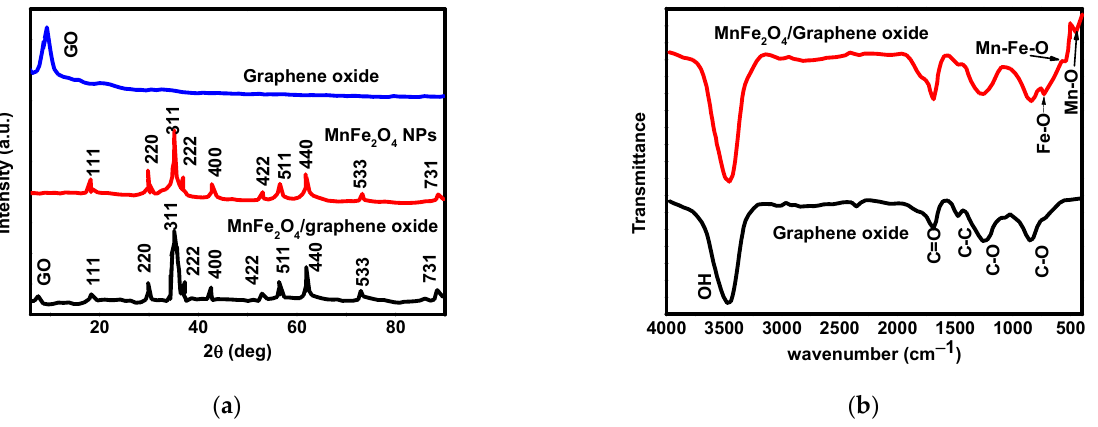
Figure 2. XRD ( a ) and FT-IR ( b ) of MnFe 2 O 4 /graphene oxide nanocomposite and its components. According to Figure 2a, XRD shows the peaks corresponding to (731), (533), (440), (511), (422), (400), (222), (311), and (220) crystal plans that appeared in both XRD of MnFe 2 O 4 and MnFe 2 O 4 /graphene oxide nanocomposite. Graphene oxide peak was observed at 12.99 ◦ that represents (001) plane. The graphene oxide plane decreased in the XRD of MnFe 2 O 4 /graphene oxide nanocomposite, indicating the reduction of graphene oxide during nanocomposite synthesis. The purity of the synthesized sample was indicated from the absence of XRD peaks related to the formation of metal oxides, either man- ganese or iron, and indicated the formation of the nanocomposite. As nanoparticles grown on graphene oxide surface preclude it from restacking, the peak of graphene oxide is sig- nificantly reduced. The average particle size of MnFe 2 O 4 nanoparticles alone and MnFe 2 O 4